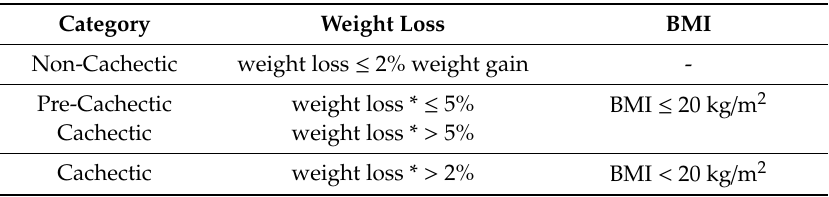
Table 1. Criteria for classification of patients as cachectic or